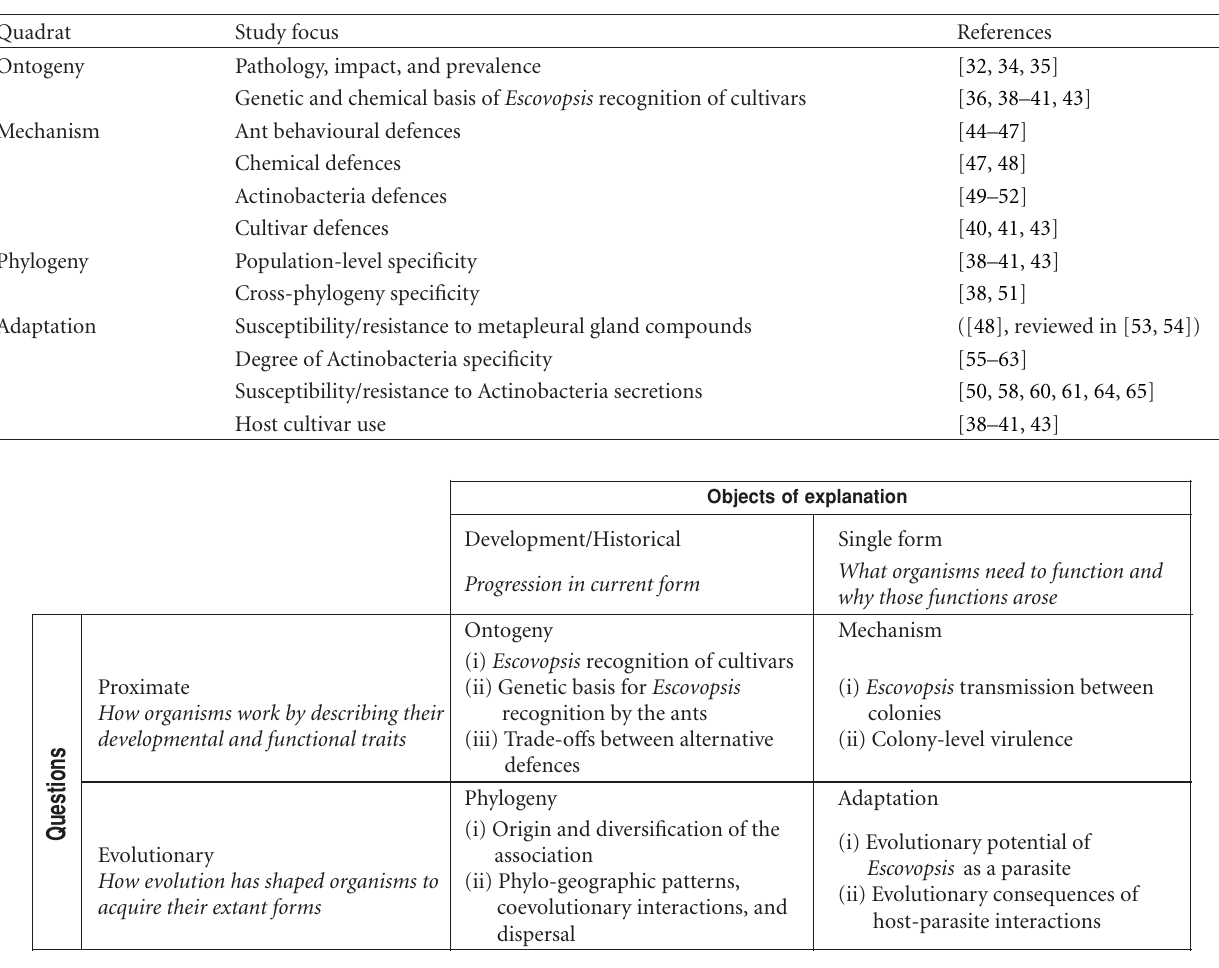
Figure 1: Tinbergen’s four quadrat framework applied to evolutionary questions about Escovopsis parasitism of fungus-farming ant crops. Ontogeny refers to the description of development, from DNA to progressive phenotype, mechanism refers to the physiological and cellular processes that organisms have available, phylogeny refers to the idiosyncratic evolutionary history of a lineage, and adaptation refers to traits that acquired their extant function because of specific selective advantages, modified from